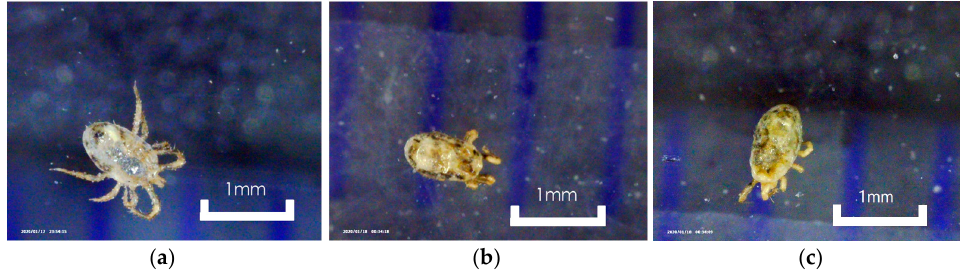
Figure 7. Comparison of D. gallinae body surfaces. ( a ) Control. ( b ) High-voltage impulse. ( c ) Heat. The color of the body surface is altered compared to the mites killed through starvation. Heat and high-voltage mite-control methods caused very similar changes in the coloration of the body surface.